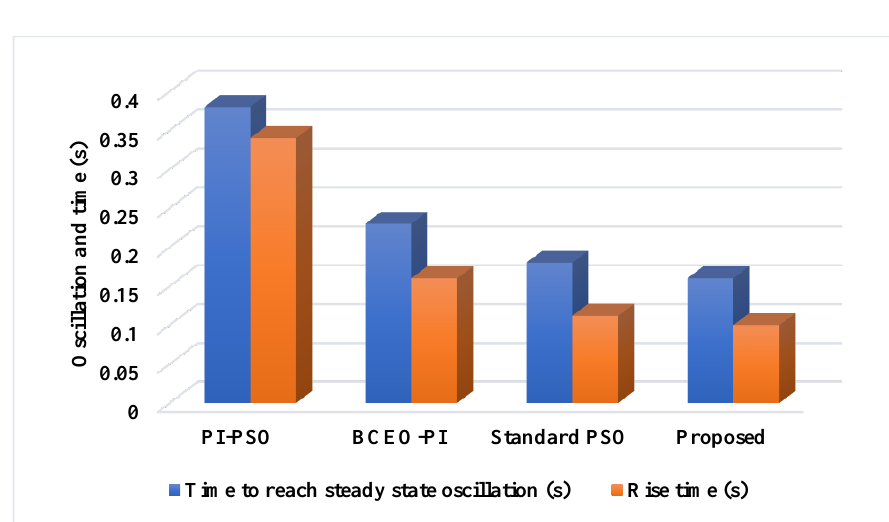
Figure 24. Comparative analysis based on rise time and steady state oscillation.